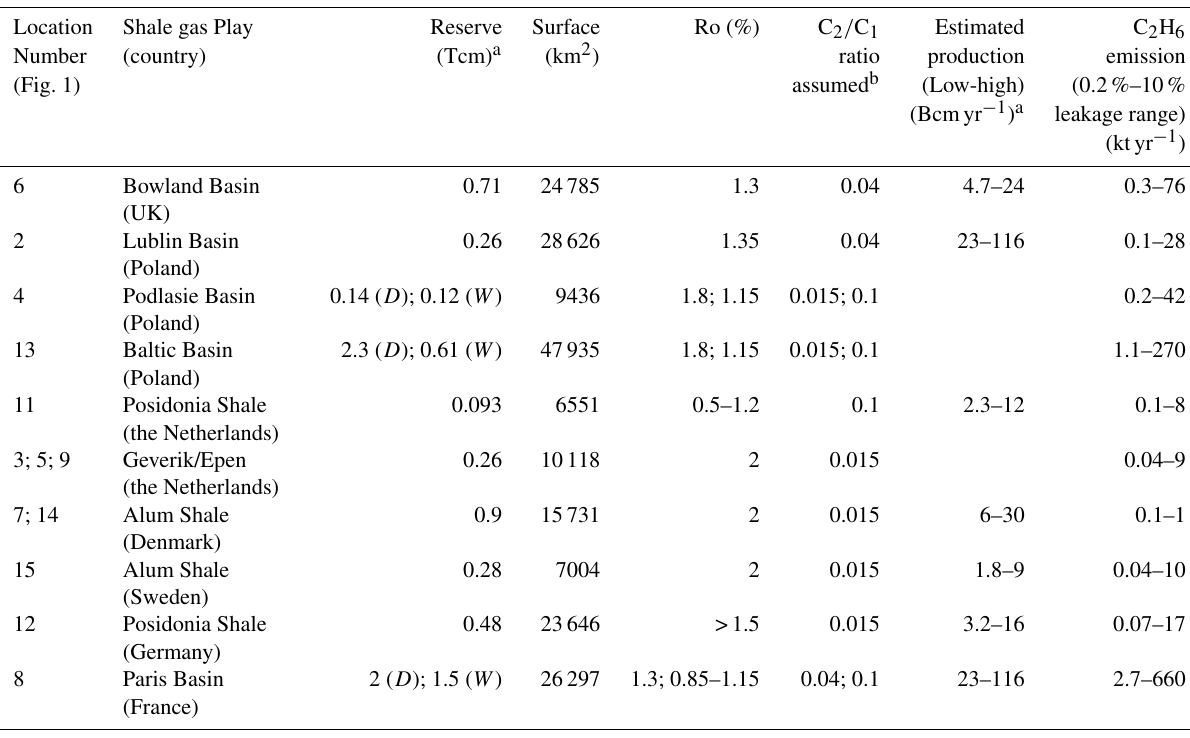
Table 1. Most promising shale gas plays in Europe based on US EIA (Kuuskraa et al., 2013) and TNO data, recoverable reserve (dry or wet gas), average thermal maturity (Ro), estimated C 2 / C 1 ratio and range of C 2 H 6 leakage rates following different shale gas production scenarios.